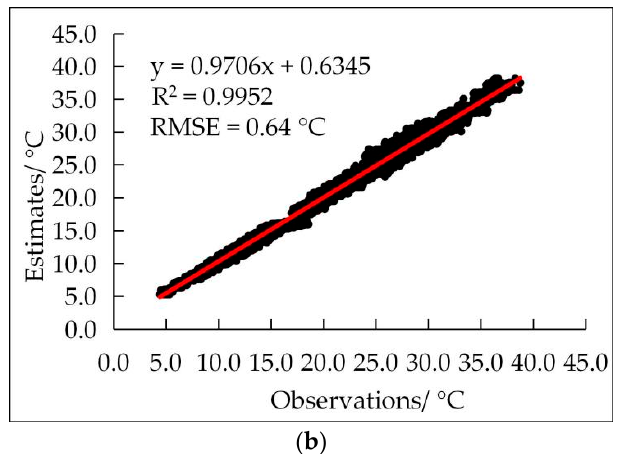
Figure A3. The linear fitting results of the observed and simulated values are reduced by 6 temper- ature sensors. ( a ) Reduced line ② ; ( b ) Reduced line ③ .